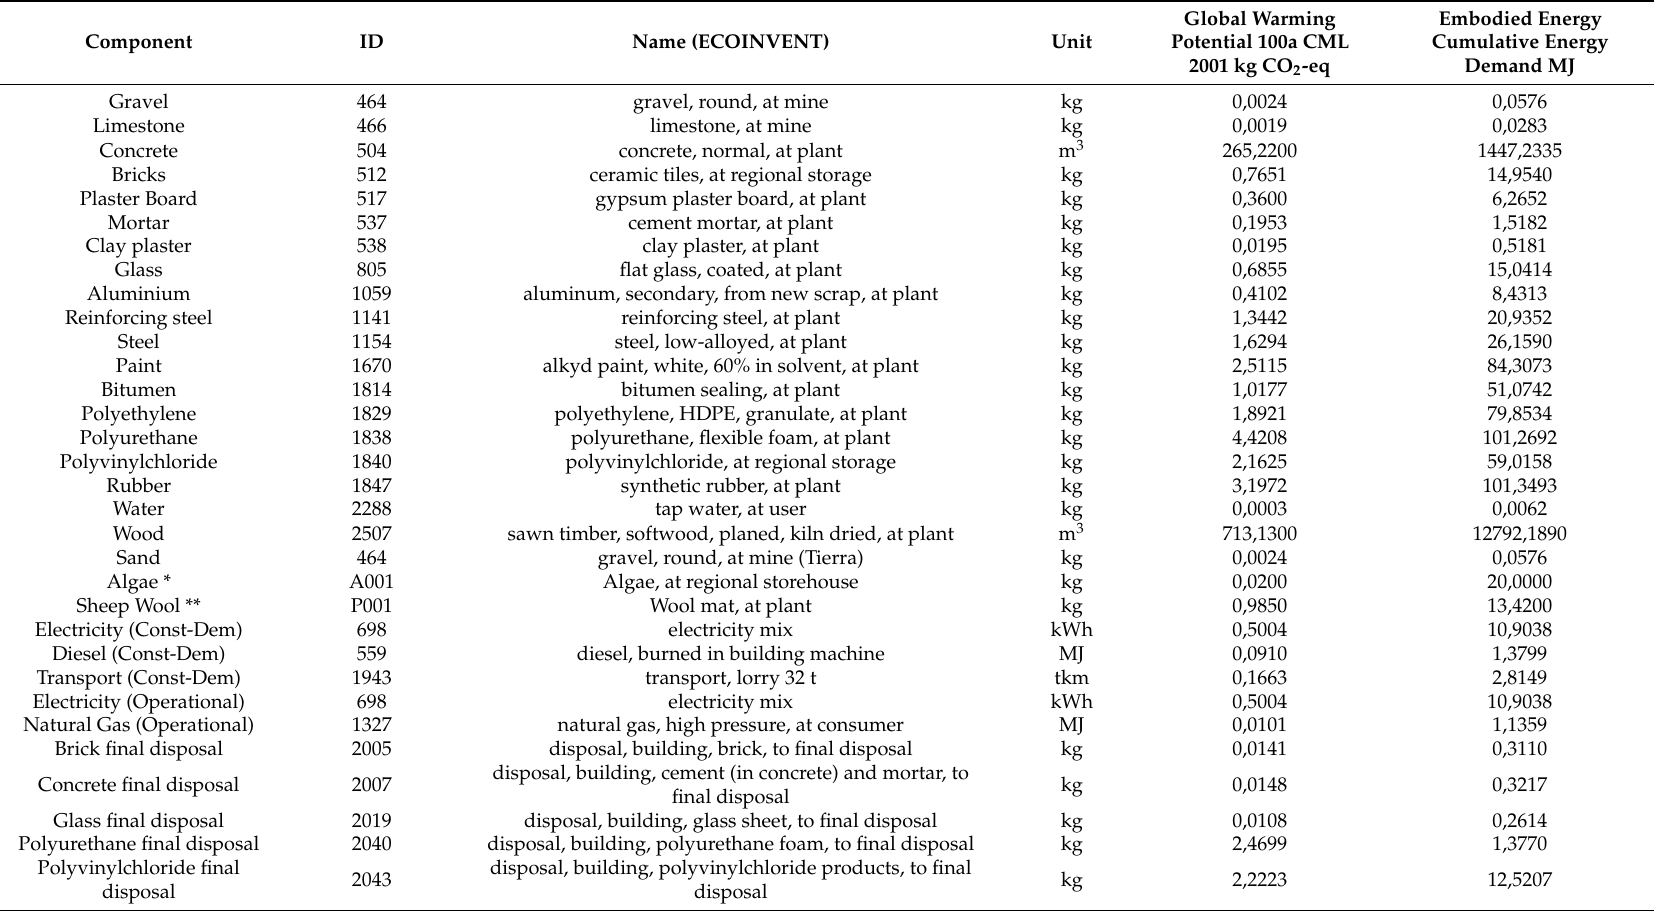
Table 3. Inventory list of the materials used and corresponding name in the ECOINVENT database. Unitary values for Global Warming Potential and Embodied Energy.